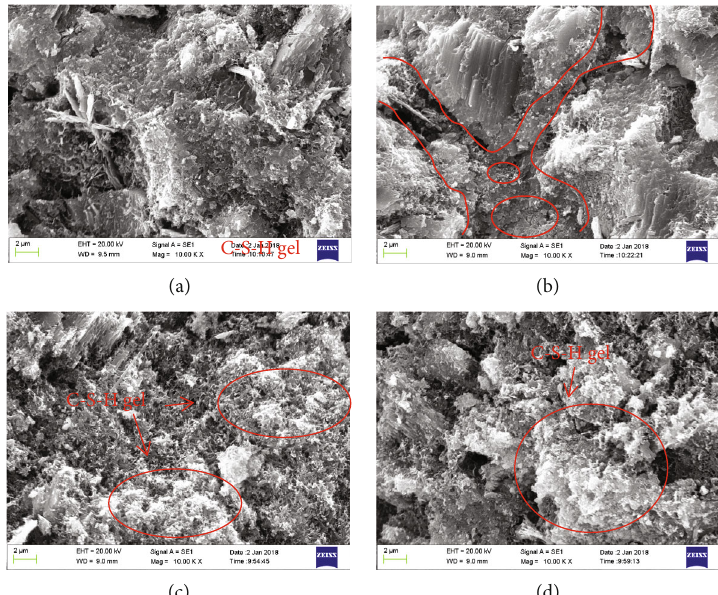
Figure 11: SEM images of hydrating cement-based material with di ff erent formulas. FLA A (0.7%BWOC) added (a, b); PVAGB/FLA A (0.2/0.5%BWOC) added (c, d). (a, c) are section direction images; (b, d) are axial direction